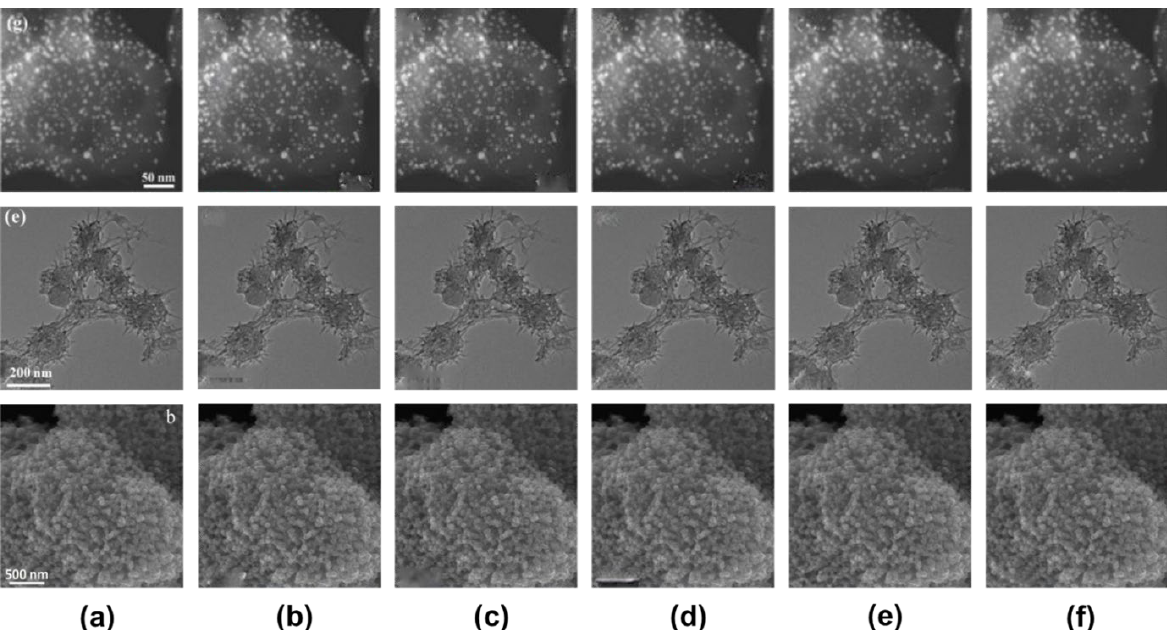
Figure 6. Comparison of the results of various image inpainting methods from the three examples of microscopic images (from top to bottom. reprinted with permission from Ref. [12]. Copyright (2020) Elsevier, from Ref. [13]. Copyright (2021) Elsevier, and from Ref. [14]. Copyright (2019) Elsevier): ( a ) represents the input image; ( b ) represents the output image of shift-net; ( c ) represents the output image of global and local; ( d ) represents the output image of contextual attention; ( e ) represents the output image of gated convolution; and ( f ) represents the ground truth.